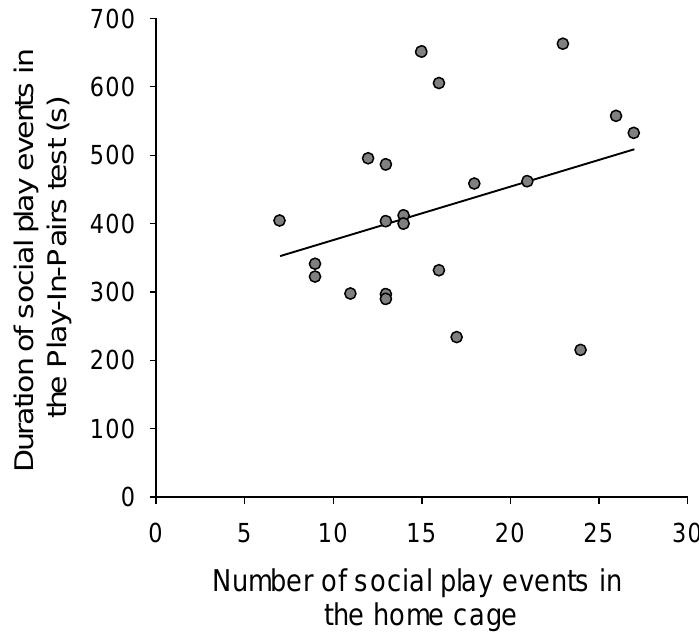
Figure 4 . Correlation between the duration of social play in the Play-in-Pairs test and the frequency of social play events in the home